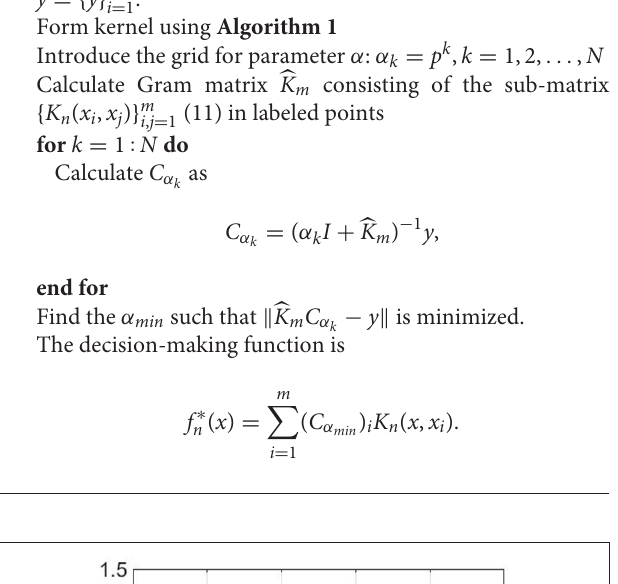
Algorithm 2: Algorithm for kernel ridge regression with the constructed kernel (11)